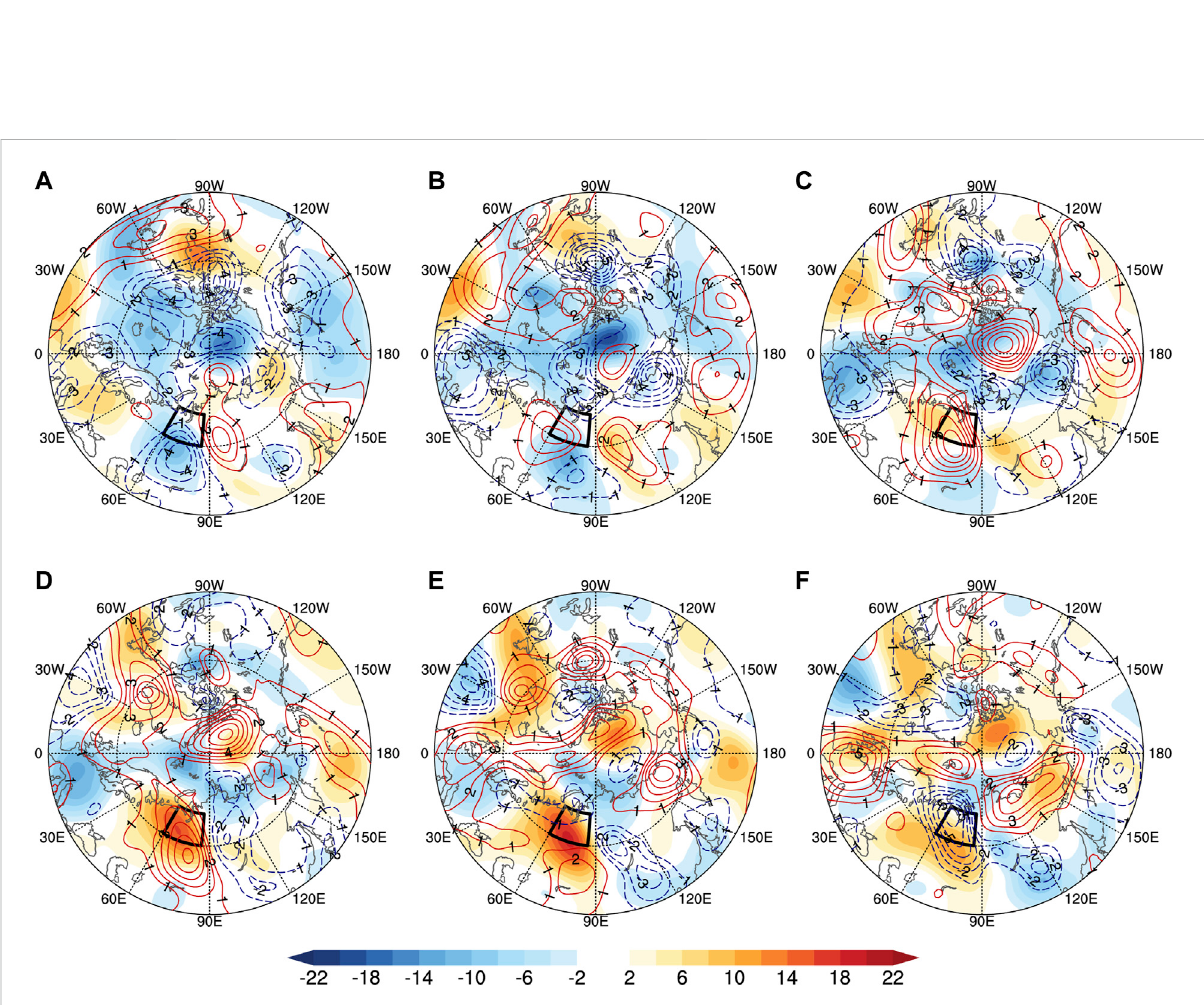
FIGURE 14 Quasi-biweekly-scalegeopotentialheightanomaly(shading)anditstendency(contour)fromday-10today0during theMeiyuonsetperiodin 1998 (A – F) (unit: gpm; black box: the mid-high-latitude key region; the latitude of the outermost line is 40 °